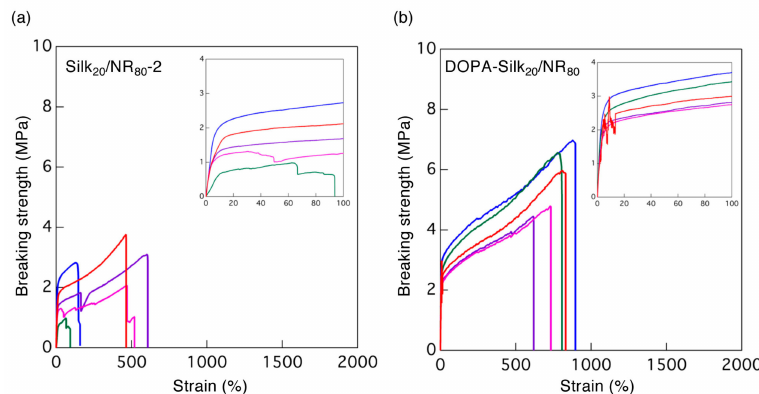
Figure 9. Stress-strain curves of ( a ) silk 20 / NR 80 -2 and ( b ) DOPA-silk 20 / NR 80 . The inset focuses on the strain range between 0 and 100%. The silk content and elongation rate were fixed at 20 wt% and 10 mm / min, respectively.